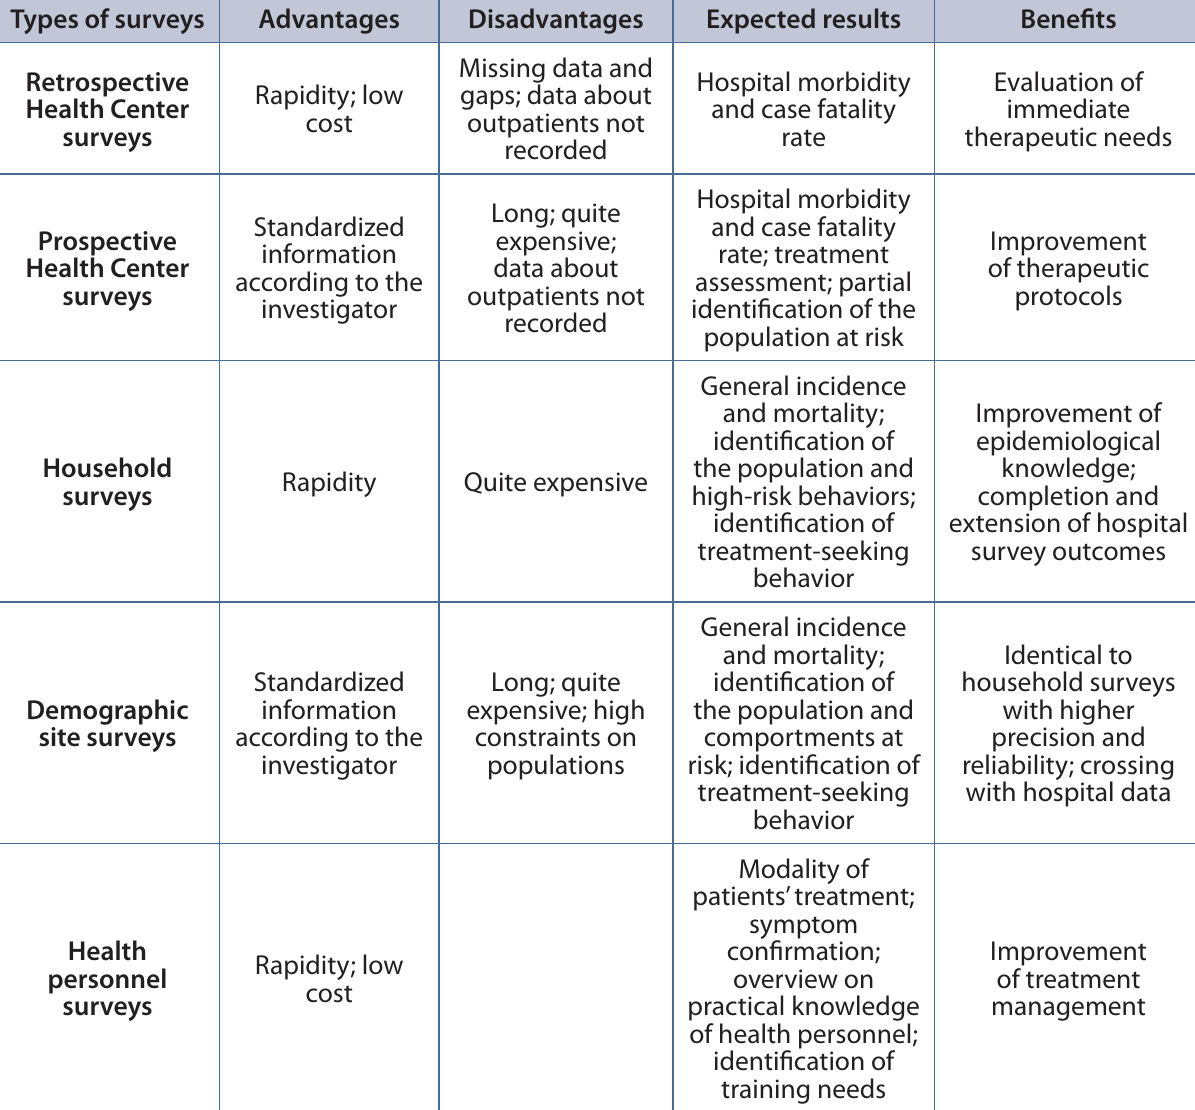
Table 1. Properties and characteristics of the different types of epidemiological studies regarding bites or stings by venomous animals Types of